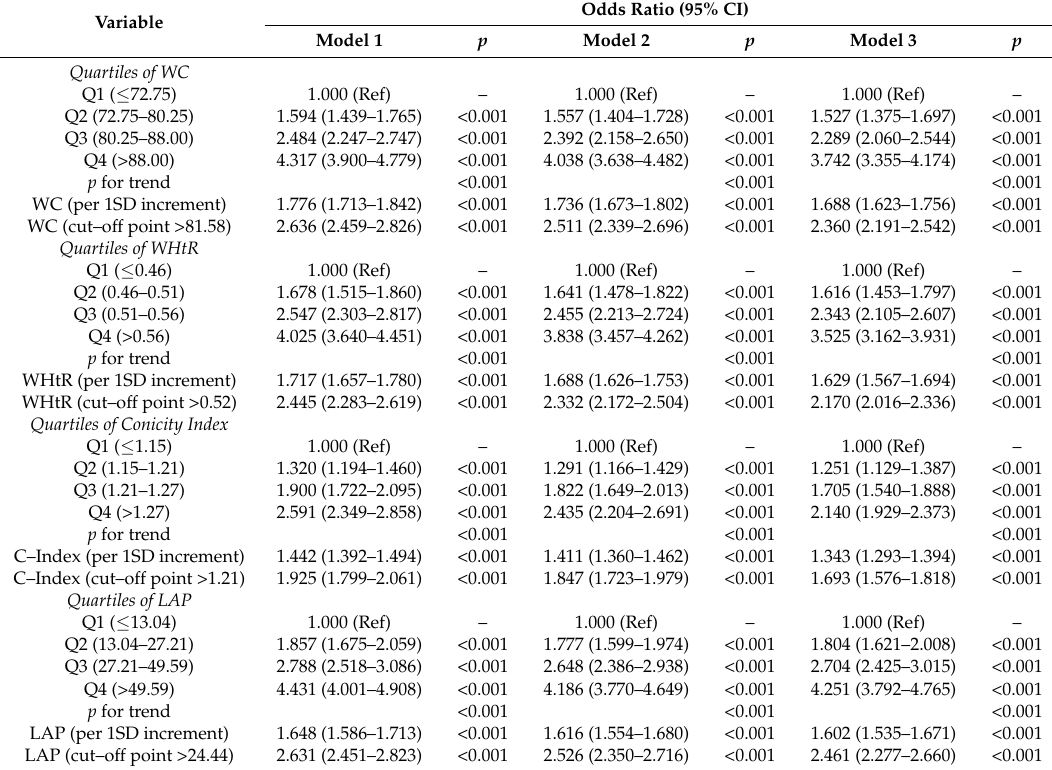
Table 5. Multivariate logistic regression of WC, WHtR, C-Index, and LAP for presence of hypertension in both